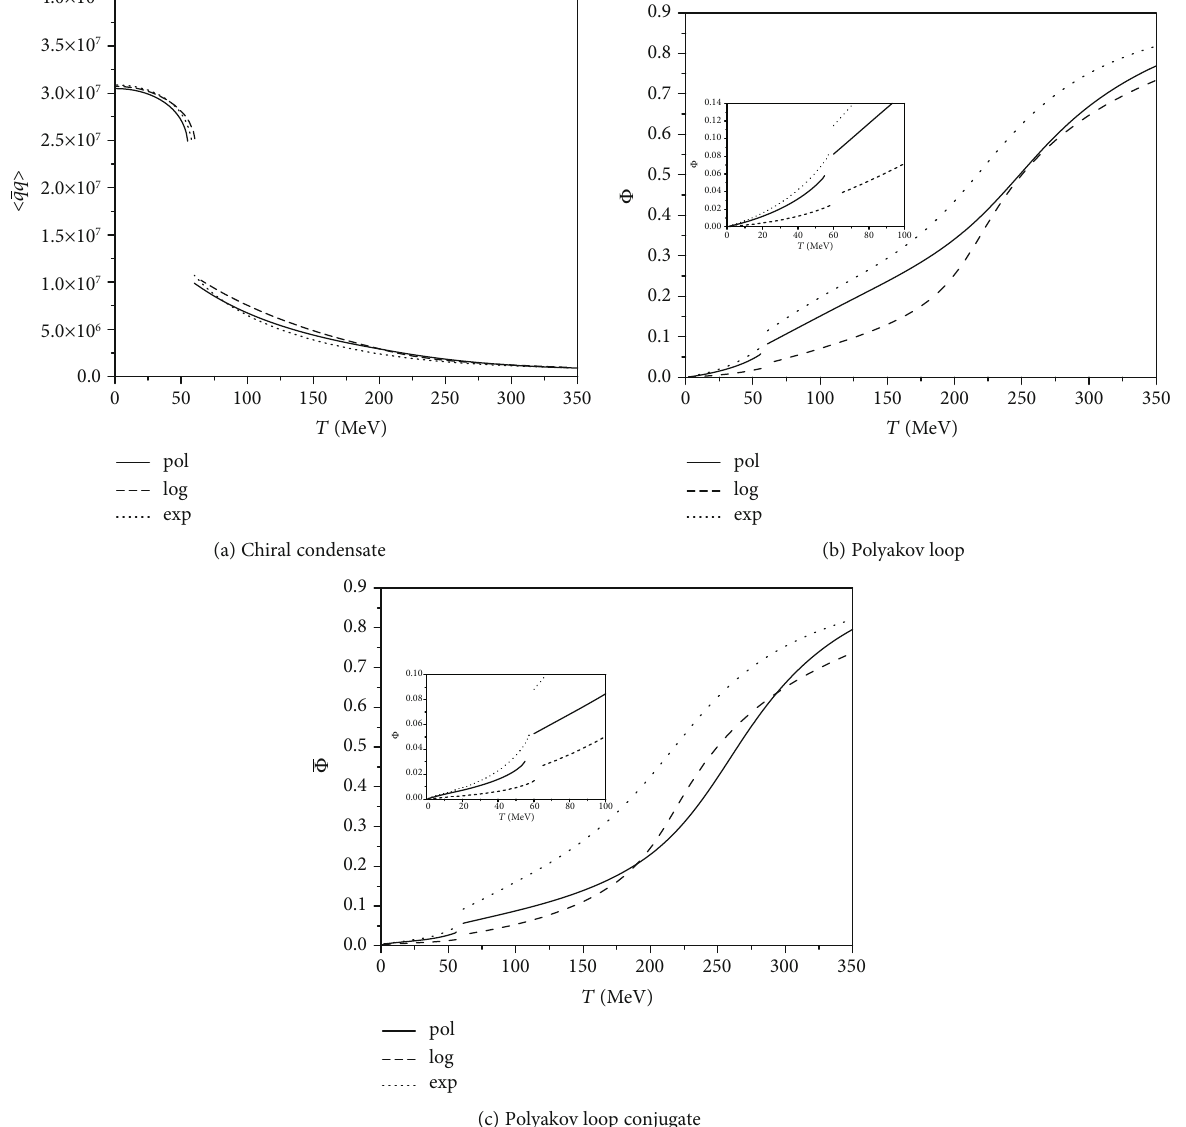
Figure 2: Order parameter as a function of temperature at μ = 340